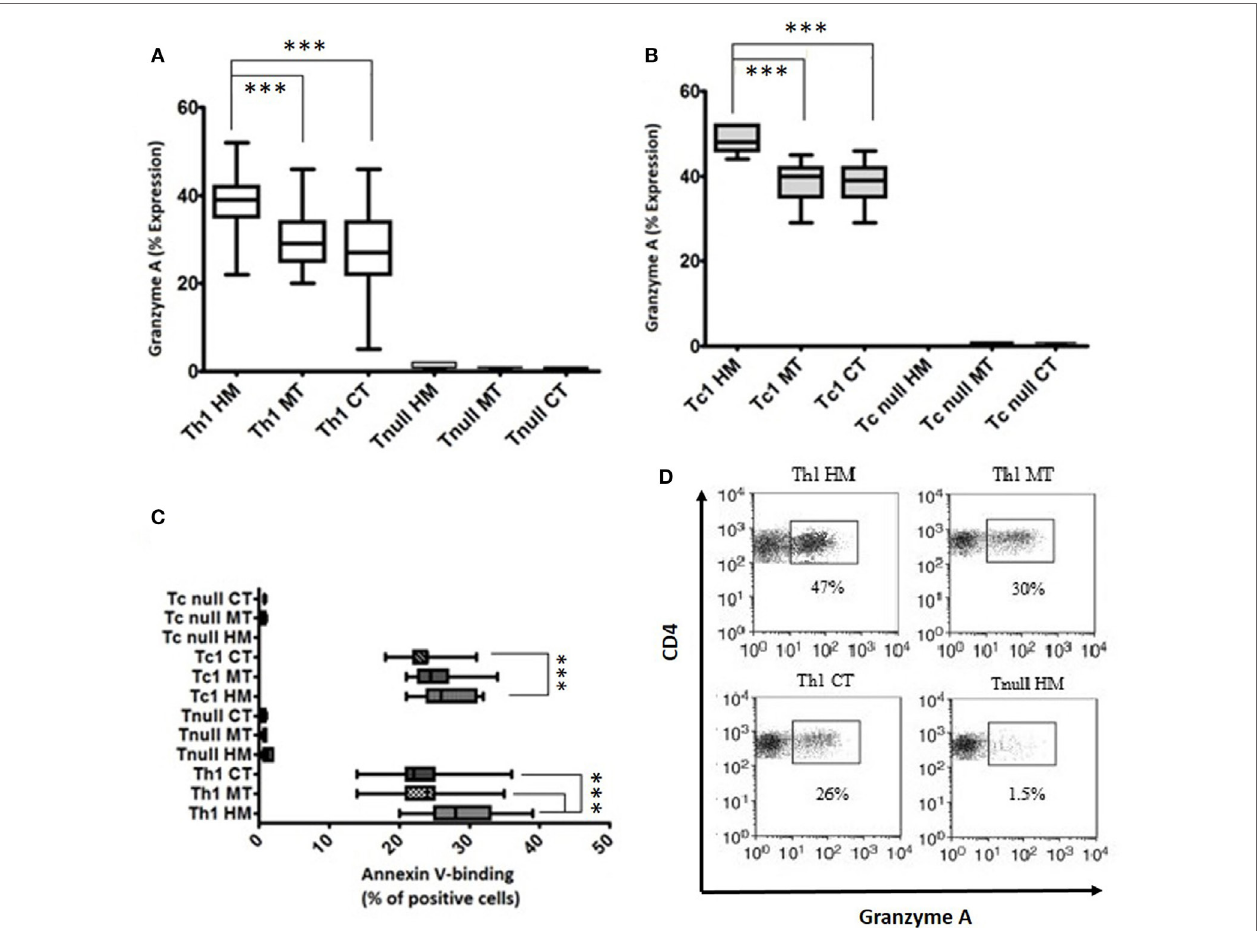
FigUre 5 | Cytotoxicity profile of T cell clones (Tcc) isolated from the different tumor sites. The granzyme A expression of CD4 + (a) and CD8 + (b) Tcc, and the percentage of annexin V-binding cells (c) were assessed according to the manufacturer’s instructions and analyzed on a FACSCanto cytofluorimeter (BD Biosciences) using FACSDiva software. The error bars represent the SD. Statistical analyses were calculated using one way ANOVA and Turkey’s post hoc . The asterisks (*) represent p -values, * p < 0.05, ** p < 0.01, *** p < 0.001. (D) A representative dot plots indicating the granzyme A expression (percentage) of CD4 + Th1 and Tnull Tcc isolated from healthy mucosa (HM), marginal tumor (MT), and central tumor